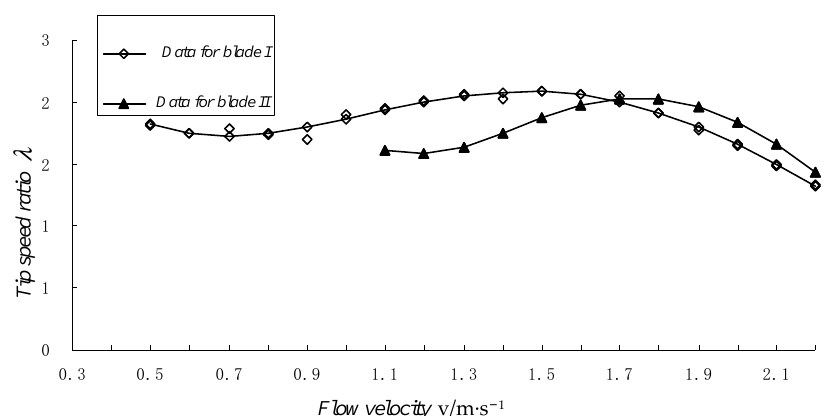
Figure 15. Tip speed ratio of the blade at different velocities.